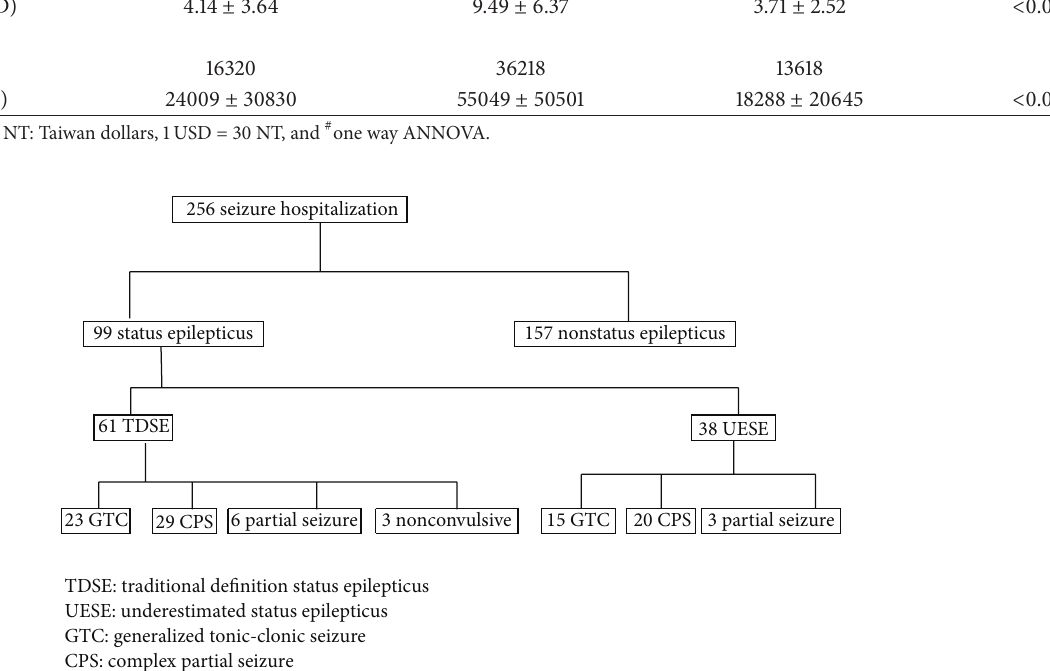
Figure 1: Flow chart of study